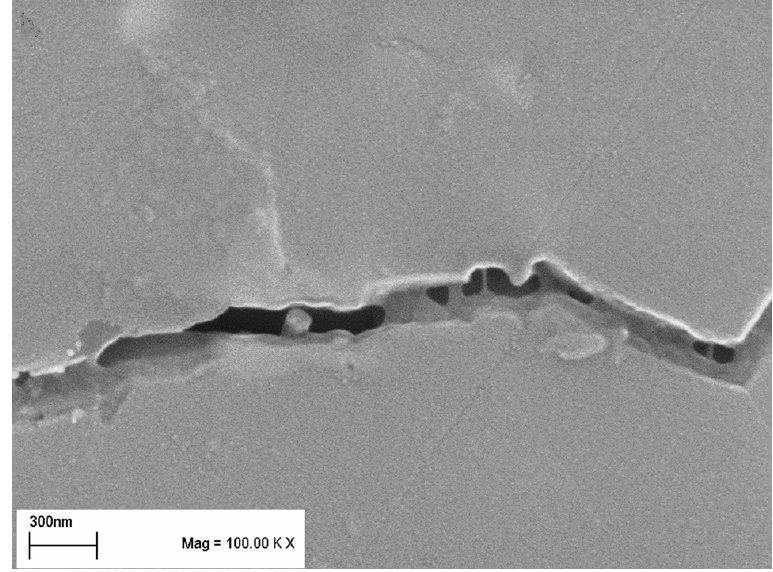
Figure 4. Indication of toughening mechanisms observed in Al 2 O 3 -ZrO 2 -MWCNT nanocomposites